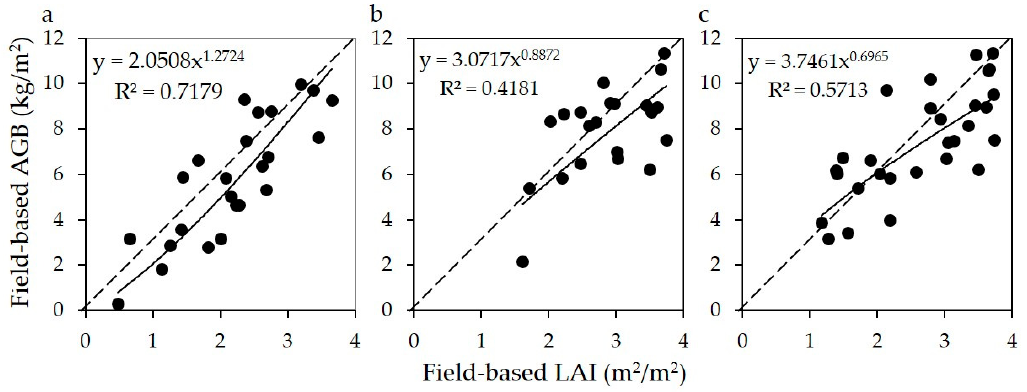
Figure 9. The relationship between field-based LAI and AGB. Inset ( a – c ) represented needle leaf, broadleaf and mixed leaf forests, respectively.